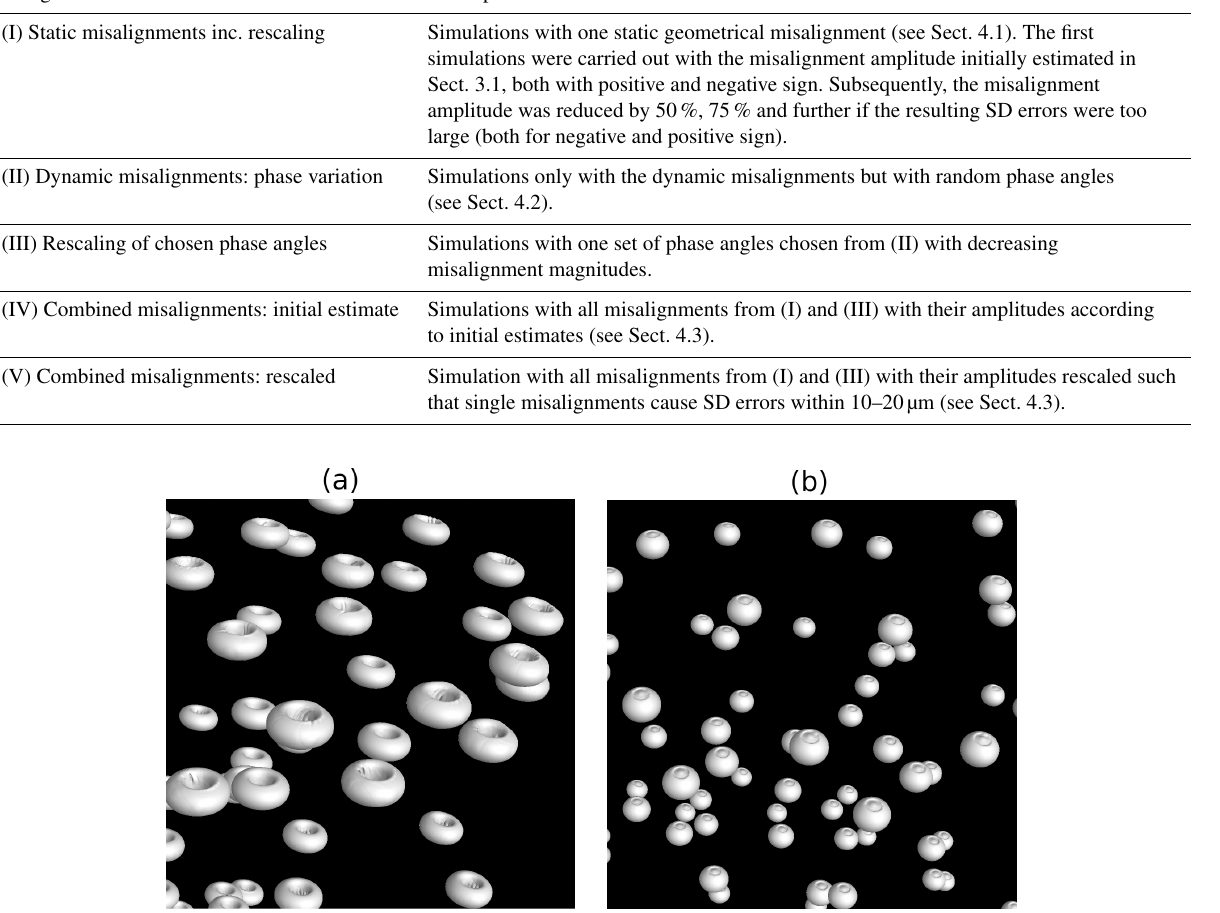
Figure 5. 3D views of the determined surfaces of the reconstructed volume data from the simulations with all static misalignments with initially estimated magnitudes (a) and 20% of those initially estimated magnitudes (b) . The views show that a CT system this heavily misaligned will not be considered for system verification as it is visually not producing correct measurements. Even with 20% misalignment, the spheres have a visible deformation from the spherical